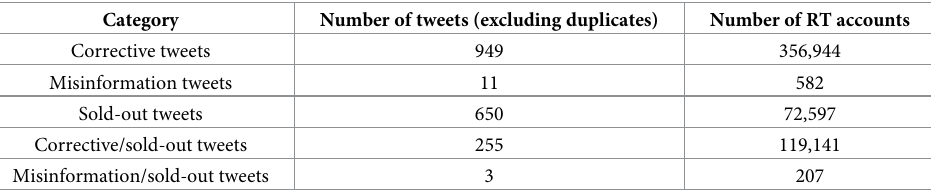
Table 1. Tweet data